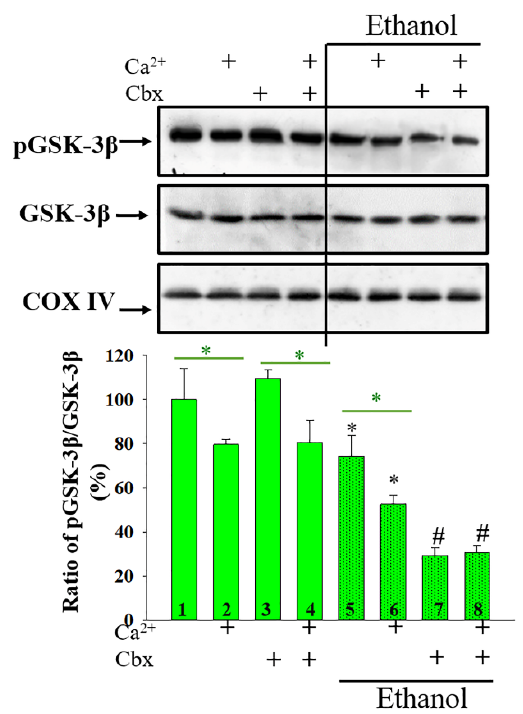
Figure 6. The phosphorylation states of stress-activated protein kinase GSK3 β in RLM. Upper parts represent Western blots of a mitochondrial suspension after the isolation of RLM (see Section 4). Lower parts—quantitation of immunostaining using computer-assisted densitometry. Bar graphs represent the ratios of pGSK3 β to total GSK3 β in the Control and Ethanol RLM. The protein band intensity was quantified after normalization with respect to COX IV. The values shown are the means ± SD from three independent experiments; The ratios of pGSK3 β to total GSK3 β in the Control RLM without additions was taken as 100%. * p ≤ 0.05 compared with the corresponding value in the Control RLM without Cbx additions with opened and closed mPTP, respectively (Columns 3, 5 vs. column 1 for the mPTP closed state and columns 4, 6 vs. 2 for the mPTP opened state), # p ≤ 0.05 compared with the corresponding value in the Ethanol RLM without Cbx additions (dotted columns 7 vs. 5 in closed mPTP and 8 vs. 6 in opened mPTP).